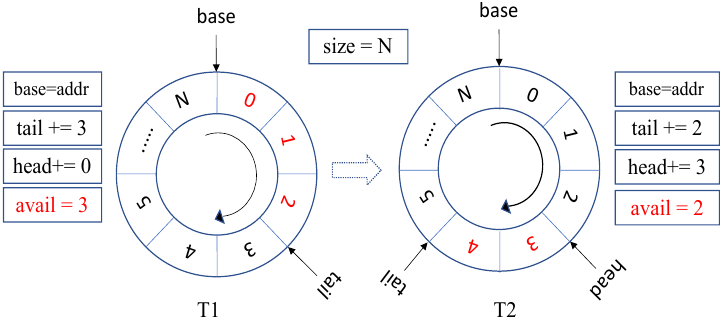
Figure 2. Hardware descriptor